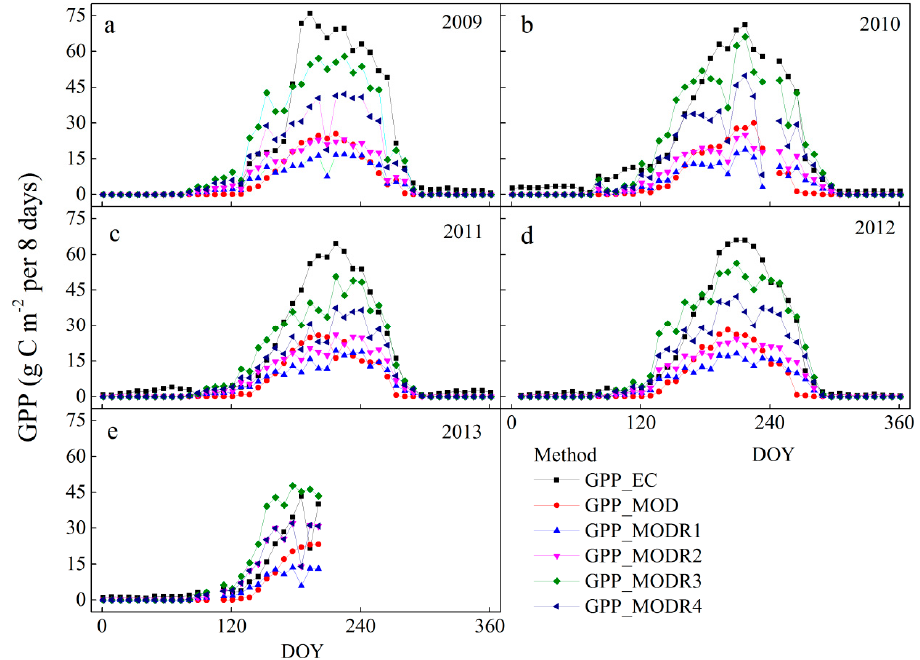
Figure 3. Seasonal variation of gross primary production (GPP) estimation from different methods from 2009 to 2013 ( a – e ). GPP_EC is from NEE partitioned of EC measurement data, while GPP estimations based on the MOD17A2 algorithm are showed in Table 1. Data are 8 days composited GPP estimation showed in the first day.